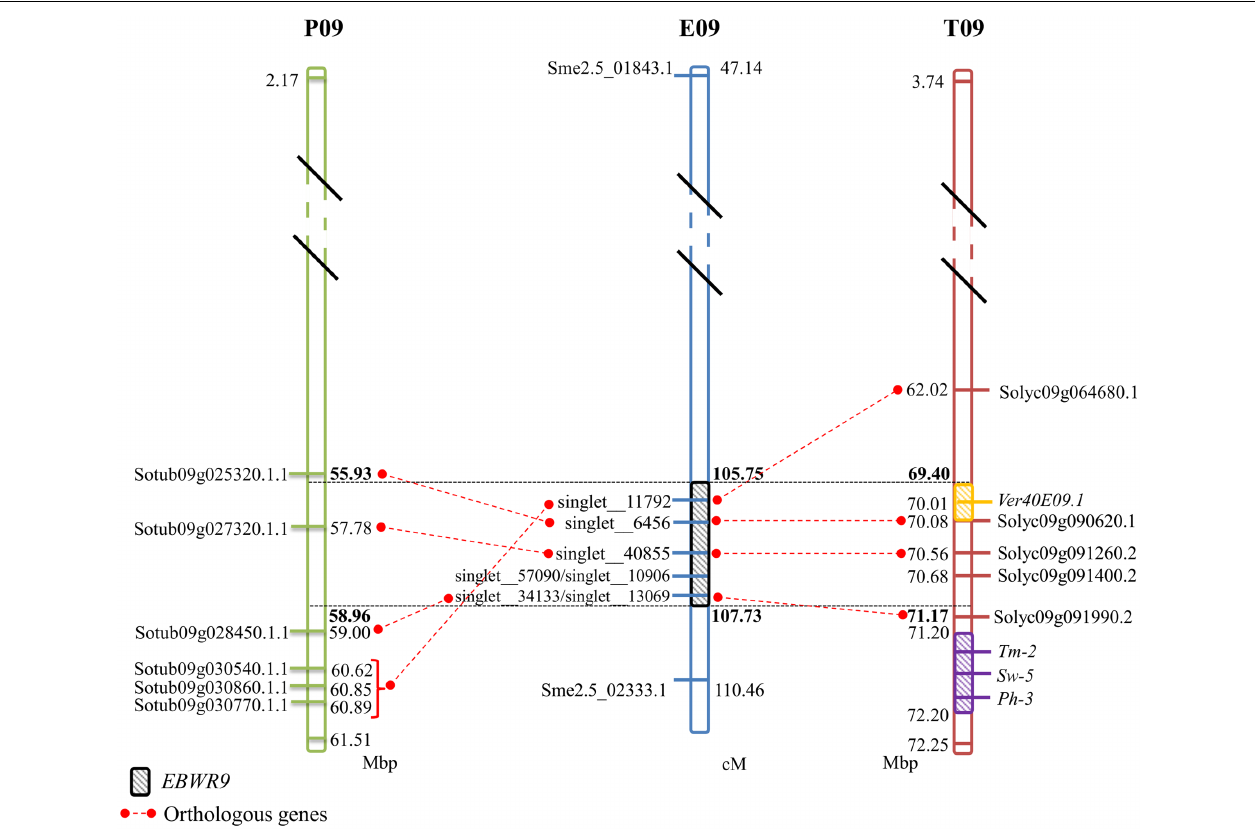
FIGURE 5 | Comparison between eggplant linkage group E09, tomato chromosome 9 (T09), and potato chromosome 9 (P09) for the synteny block 35, where EBWR9 major QTL for bacterial wilt resistance is located. Position of EBWR9 and the candidate genes identified in the P1 (MM738) transcriptome are indicated on E09. Physical position of candidate genes from the ITAG2.4 transcriptome and QTLs/genes controlling tomato resistance to Verticillium dahliae resistance ( Ver40E09.1 ), tomato spotted wilt virus ( Sw-5 ), tomato mosaic virus ( Tm-2 ) and Phytophthora infestans ( Ph-3 ) identified in previous studies are indicated on T09. Orthology between eggplant, tomato and potato genes (ST1.0 transcriptome) is indicated by red dotted lines. Map distances (cM) are shown on the right of E09 and physical distances (Mbp) are shown on the right of P09 and on the left of T09. Position of the EBWR9 interval on P09, T09, and T09 are printed in bold font. Distances are not